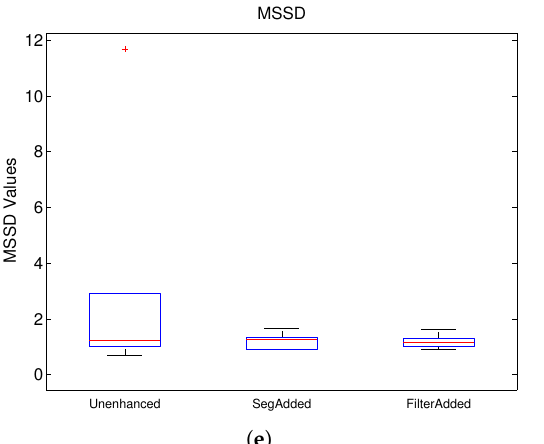
Figure 9. Comparison of segmentation of filtered images with combination of filters. ( a ) DICE; ( b ) ASSD; ( c ) RAVD; ( d ) VOE; ( e ) MSSD.